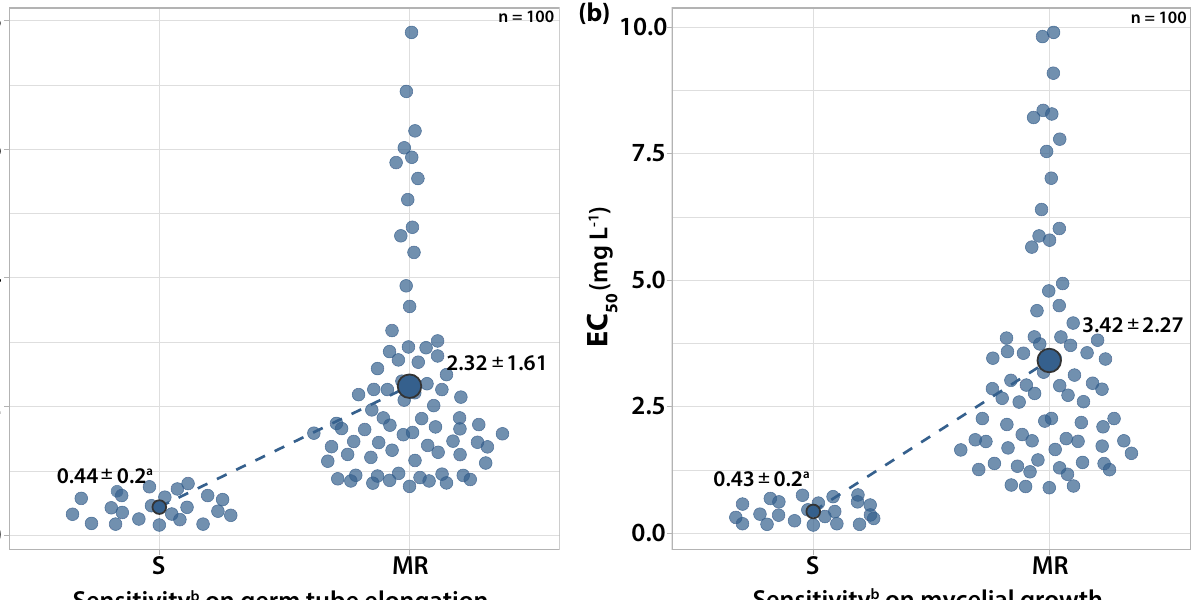
Figure 3. Frequency of sensitivity distribution for one hundred V. inaequalis isolates to cyprodinil on ( a ) germ tube elongation and ( b ) mycelial growth. The mean EC 50 values for the moderately resistant population of V. inaequalis were significantly higher ( p < 0.05) than the mean EC 50 val- ues of the sensitive population on both tests according to the Welch’s t -test. a Average values of sensitivity groups ± standard deviation; circle size reflects the population number. b Sensitivity groups: S, sensitive; MR, moderately